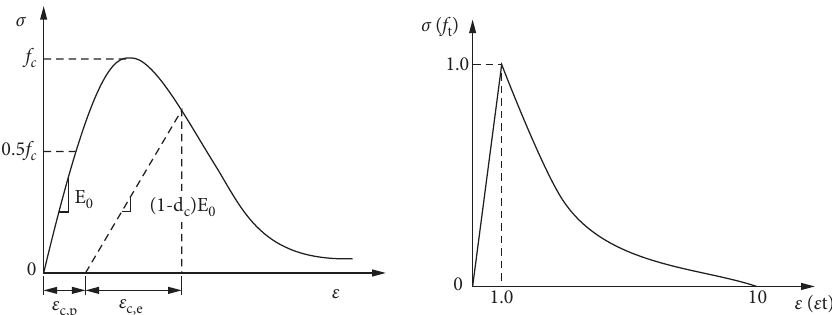
Figure 22: Concrete damage plasticity models compressive and tensile stress-strain relationships.